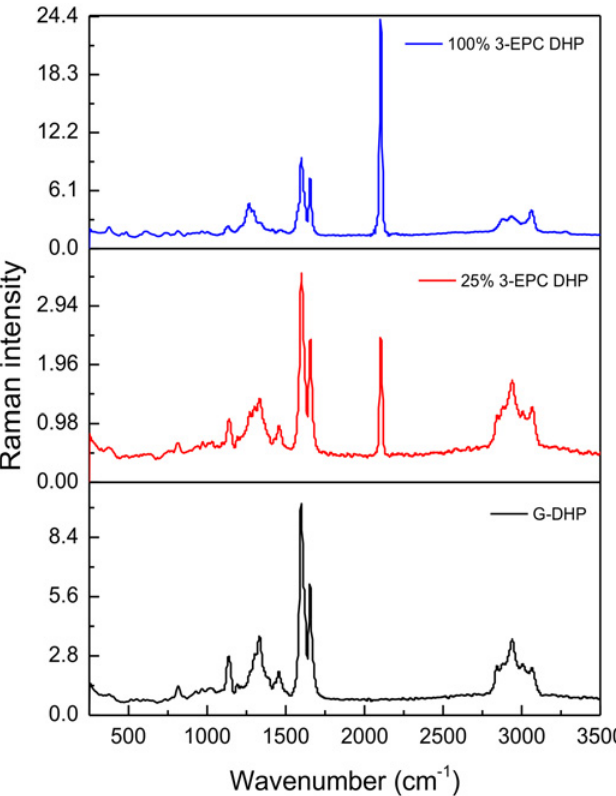
Fig 4. Raman spectra of DHPs. Spectra (1024 nm excitation, 500 scans, data spacing of 1.928 cm -1 ) of in vitro -synthesized DHP with 100% CA (black trace); DHP with 25% 3-EPC + 75% CA (red trace); and DHP with 100% 3-EPC (blue trace). The red and blue spectra show a characteristic terminal alkyne peak at 2100 cm -1 .